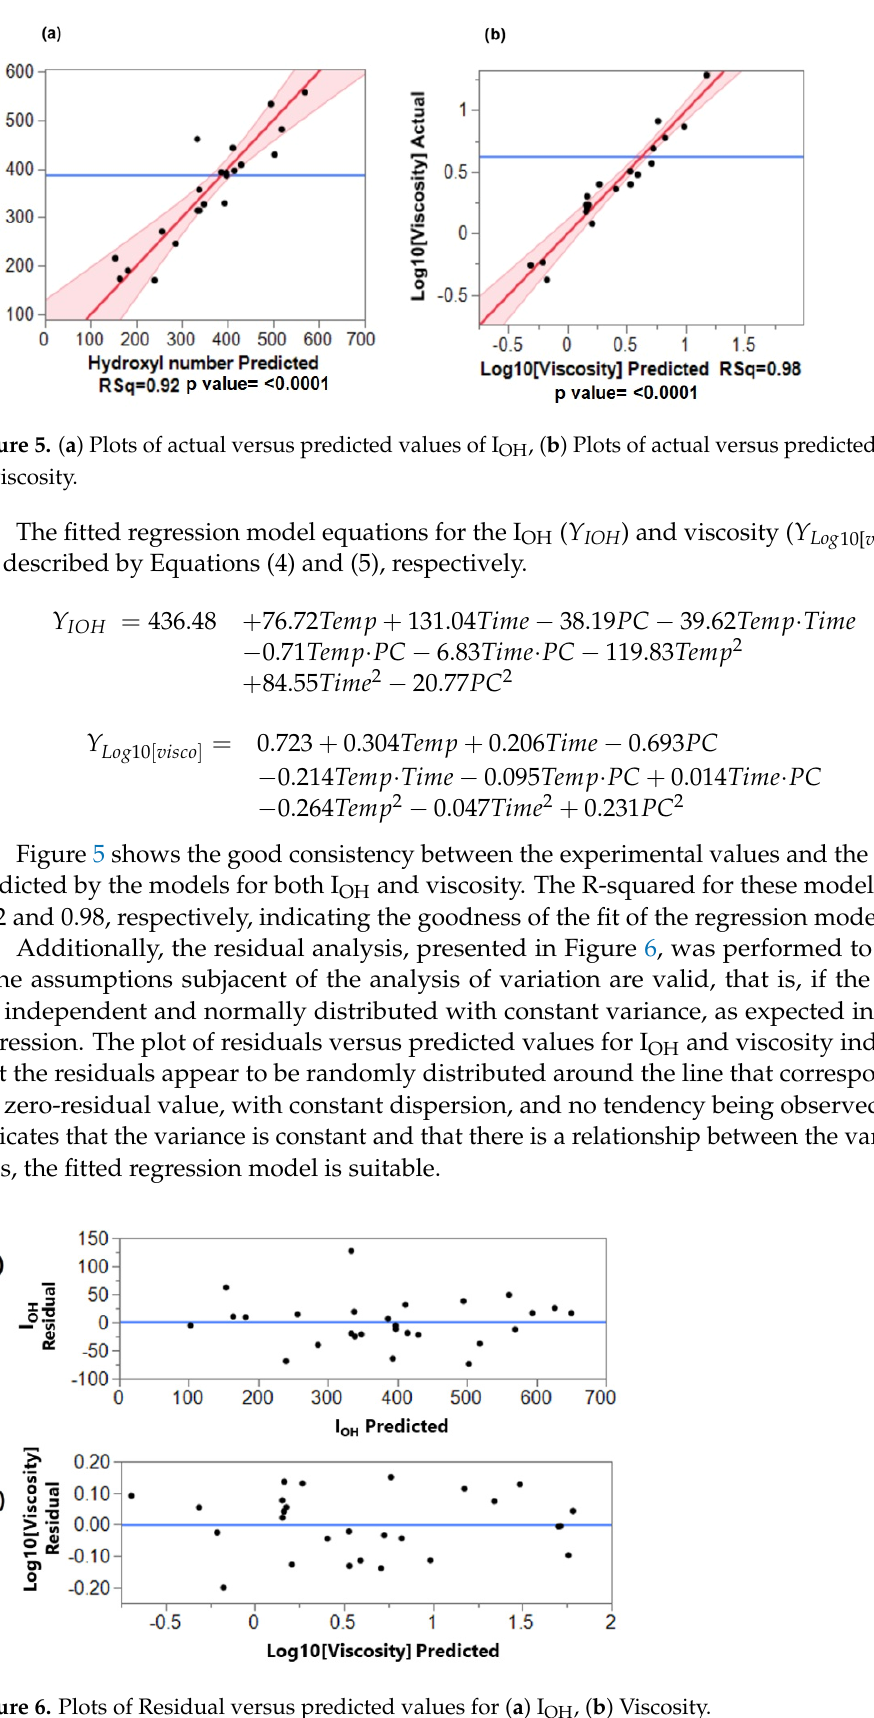
Figure 4. ( a ) Plots of actual versus predicted values of viscosity, ( b ) Plot of viscosity residual versus predicted values.